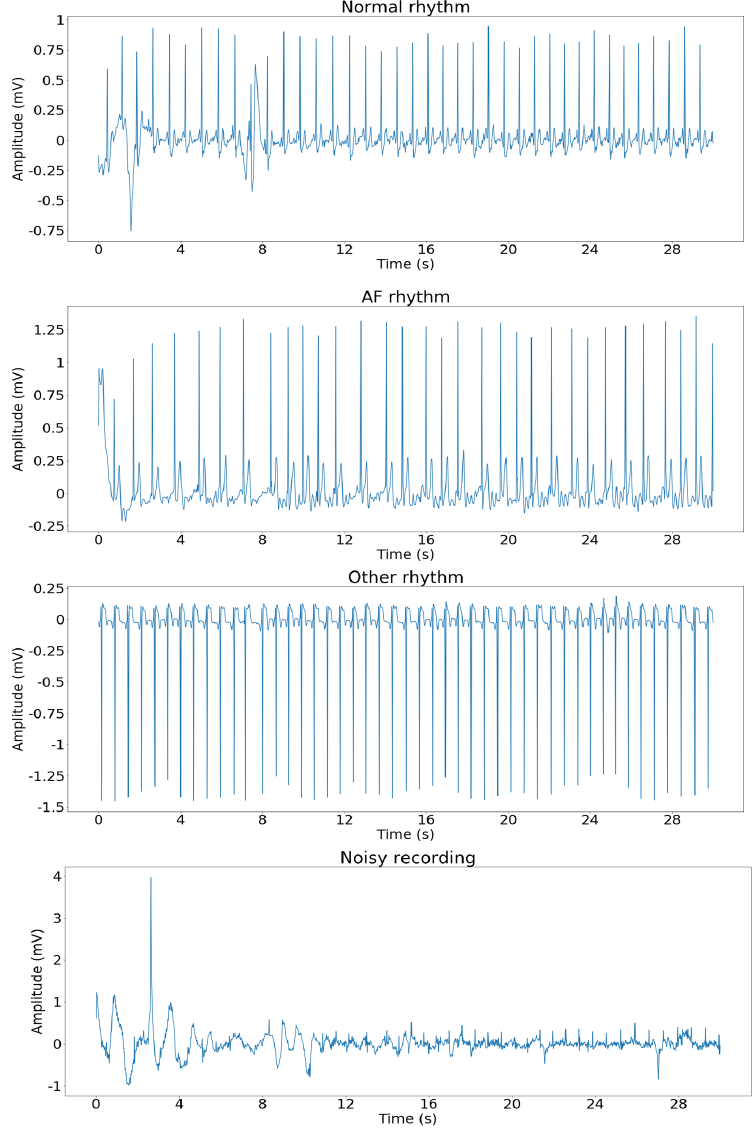
Figure 1. Examples of different classes of ECG